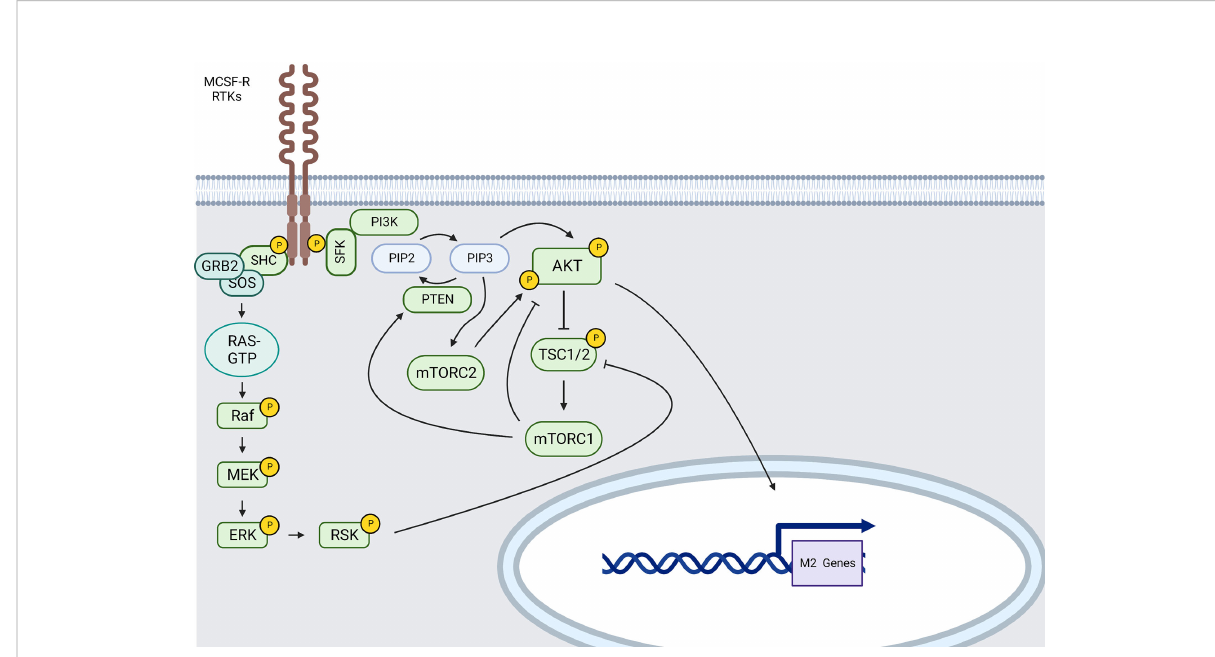
FIGURE 4 MCSF-R and RTKs main signaling pathways involved in M2-like polarization (created using BioRender ®